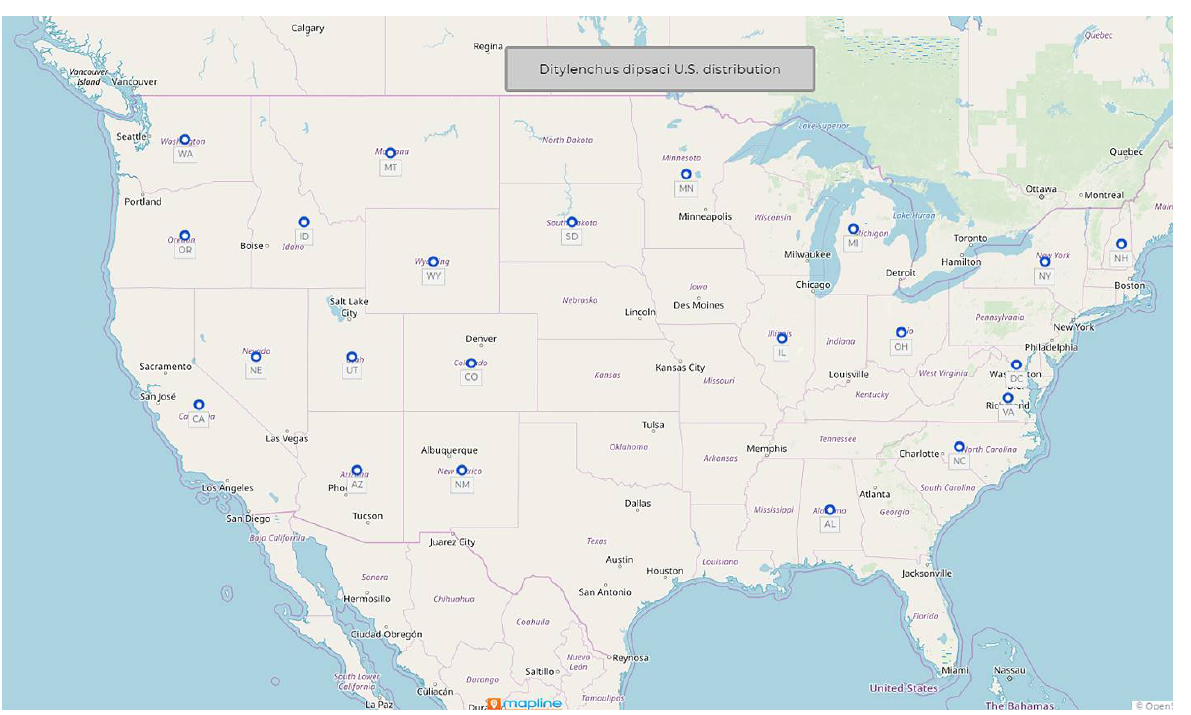
Figure 2. Distribution map of Ditylenchus dipsaci (adapted from CABI-ISC) [26]. Symptoms : Damage symptoms caused by this nematode change with host. Most com- mon symptoms include stunting, crinkling, twisting, swelling, or malformation of the leaves, leaf stalks, flowers, and stems. Infested tissue may also split